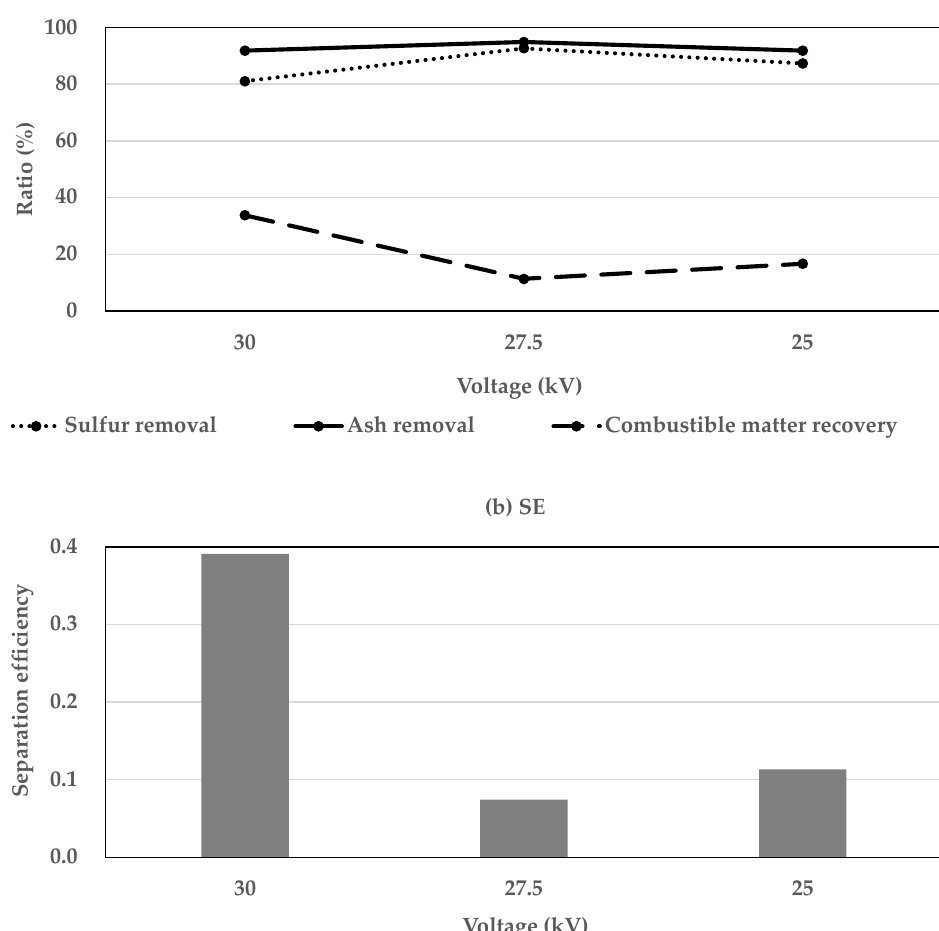
Figure 4. Performance of coal separation at different electrode voltages: ( a ) ash removal ratios (%), sulfur removal ratios (%), and combustible matter recovery ratios (%); ( b ) efficiency of coal separation using a dry coal cleaning system with two-stage corona electrostatic processes.